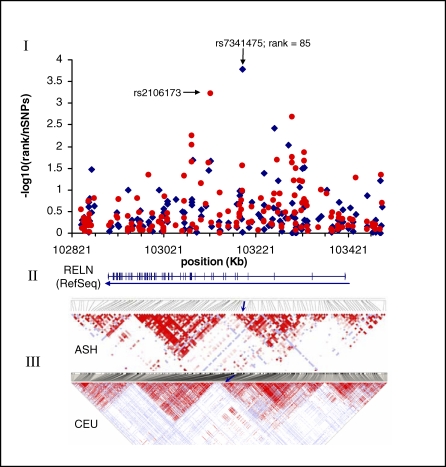
Association Signal for Schizophrenia in the Reelin Gene(I) The −log values are the negative logarithm (base 10) of the rank of each SNP divided by the number of SNPs on the array. The rank is based on a silhouette statistic [36], calculated separately for DNA pools of men (red) and women (blue) using the GenePool software. Arrows indicate the most significant SNPs, genotyped individually. The signal from rs2106173 was found to be an artifact of the DNA pooling experiment. (II) The structure and location of the reelin gene is from the Genome Browser of the University of California, Santa Cruz. Blue boxes represent the gene exons. (III) Similar patterns of linkage disequilibrium (LD) in Ashkenazi Jewish population (ASH) and individuals with European ancestry from HapMap (CEU). The blue arrows indicate the position of SNP rs7341475. Figures were generated using the Haploview software (http://www.broad.mit.edu/mpg/haploview/), with the standard color scheme. Pairwise LD levels between the SNPs in the region are represented by the color of the squares, which increase from white to blue to red (white, disequilibrium coefficient (D') < 1 and LOD score < 2; blue, D' = 1 and LOD score < 2; pink or light red, D' < 1 and LOD score ≥ 2; and bright red, D' = 1 and LOD score ≥ 2).